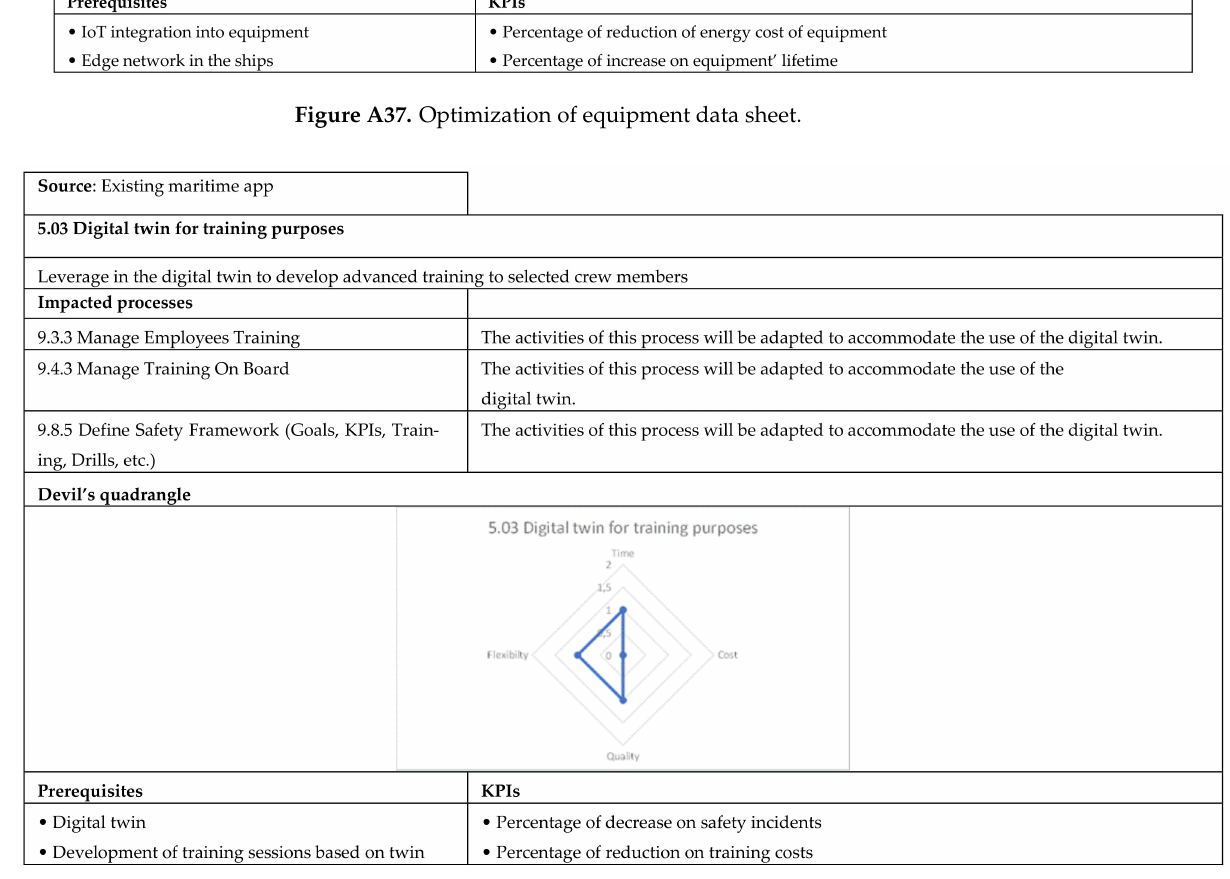
Figure A38. Digital twin for training purposes data sheet.